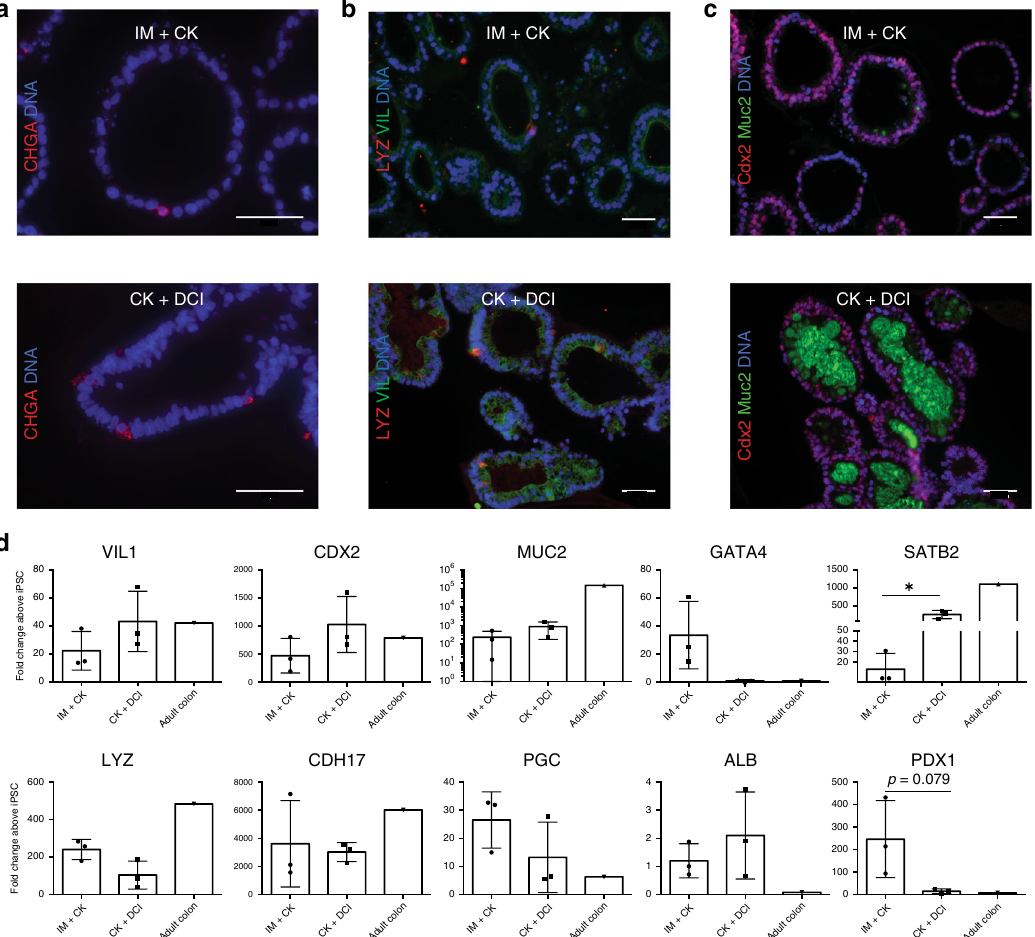
Fig. 6 CDX2 GFP + sorted organoids show conserved regional speci fi city. a – c Sections of paraf fi n embedded organoids cultured in either IM + CK or CK + DCI stained for Chromogranin A (CHGA), Lysozyme (LYZ), Villin (VIL), Cdx2, and colonic mucin Muc2 (scale bar = 50 μ m, representative of n = 5 organoids from n = 2 differentiations). d qRT-PCR for various genes of interest, from D54 HIOs cultured in either CK + DCI or IM + CK as compared with a primary control normalized to day 0 hiPSCs (2 − ΔΔ CT , technical triplicates normalized to GAPDH or ACTB ( β -ACTIN), n = 3 differentiations, error bars represent the s.d., statistical signi fi cance where indicated determined by unpaired Student ’ s t -test, * p <